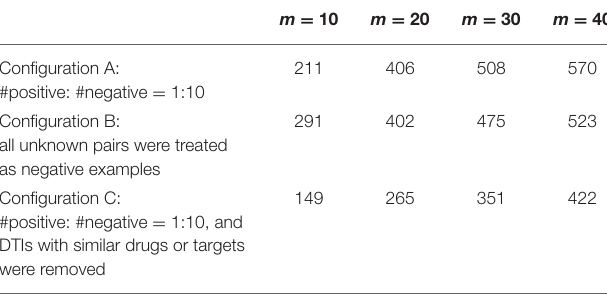
TABLE 2 | Hit numbers of GADTI in different